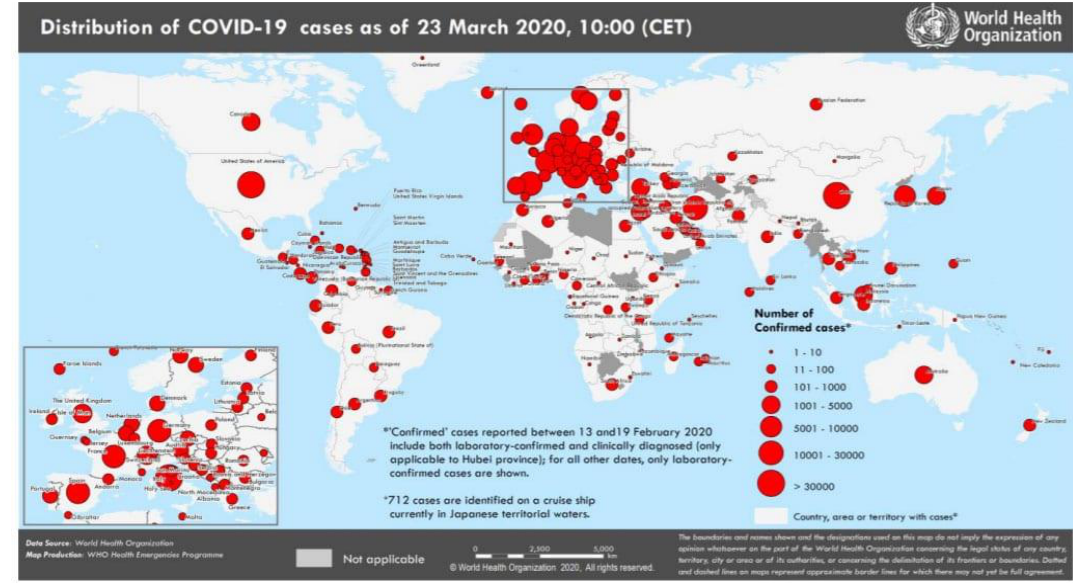
Figure 1. Figure 1. World Health Organization (WHO) situation report 63 (https: // www.adb.org / publications /